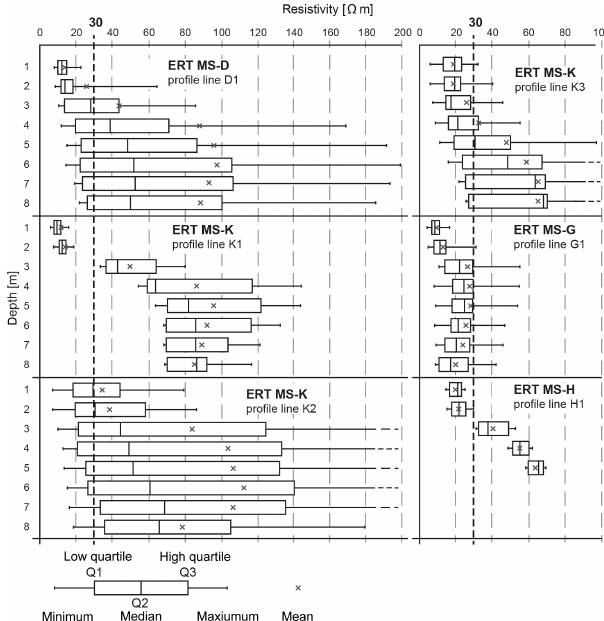
Figure 7. Box plots of measured resistivity at depths from 0 to 8m over the entire measuring profile. Value range for depth 1: 0 < to ≤ 1m; 2: 1 < to ≤ 2m; and so